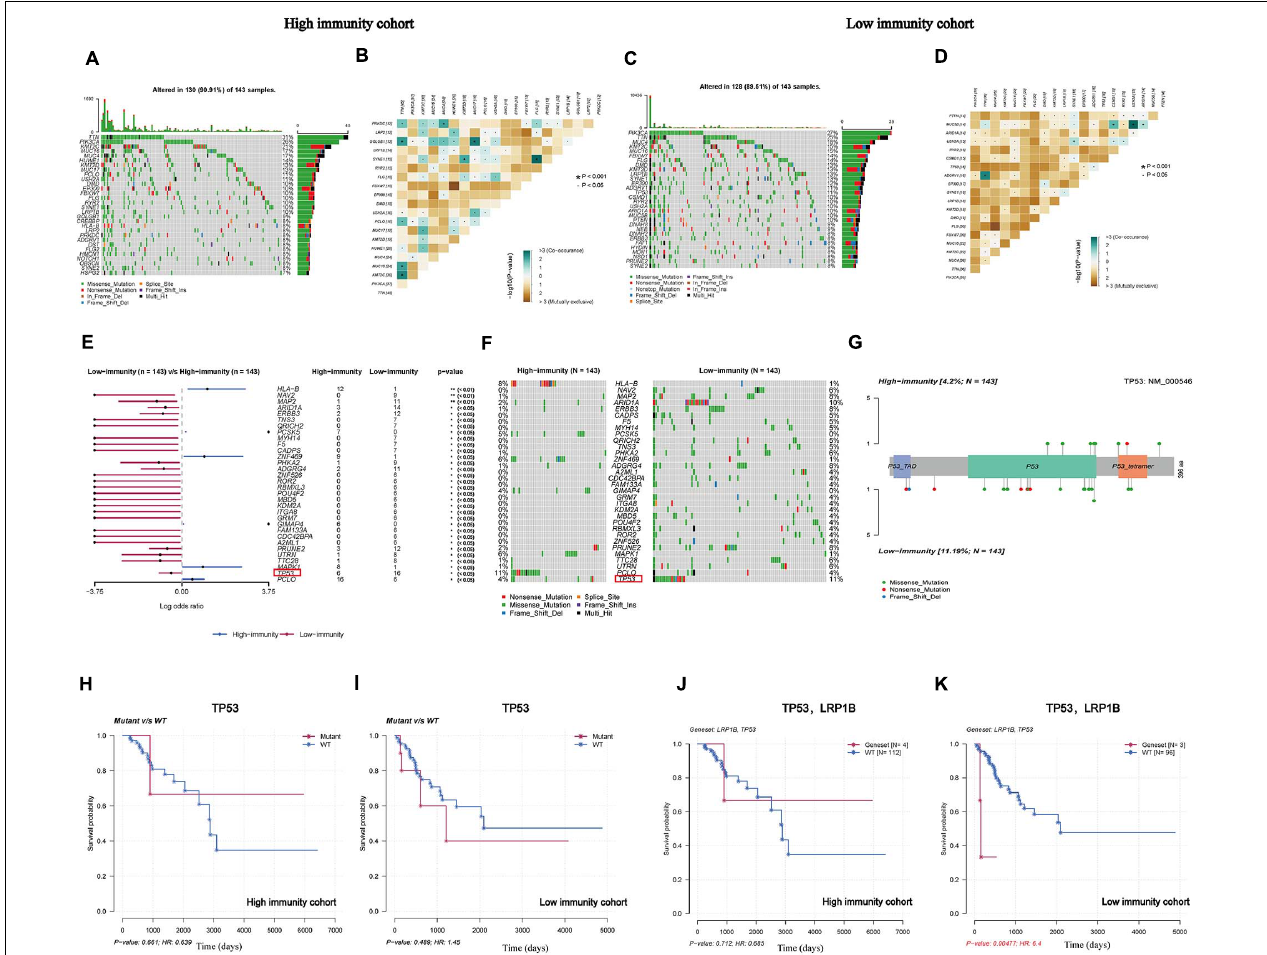
FIGURE 4 | Landscape of somatic mutation in high-immunity and low-immunity cohorts. (A,C) The waterfall plot shows the mutation distribution of the top 30 most frequently mutated genes. The central panel shows the types of mutations in each CC sample. The upper panel shows the mutation frequency in each CC sample. The bar plots on the left and right sides show the frequency and mutation type of genes mutated in the low-immunity and high-immunity cohorts, respectively. The bottom panel is the legend for the mutation types. (B,D) The heatmap illustrates the mutually co-occurring and exclusive mutations of the top 20 frequently mutated genes. The color and symbol in each cell represent the statistical significance of the exclusivity or co-occurrence for each pair of genes. (E,F) The forest plot and waterfall plot display the significantly differentially mutated genes between the two cohorts; tumor protein p53 (TP53) is marked in the red rectangle. (G) The lollipop plot illustrates the differential distribution of variants of TP53. (H,I) The Kaplan-Meier curves show the independent relevance between overall survival time and TP53 mutation in the high-and low-immunity cohorts. (J,K) The Kaplan-Meier curves show the independent relevance between overall survival time, TP53, and low-density lipoprotein receptor-related protein 1B (LRP1B) mutation in high- and low-immunity